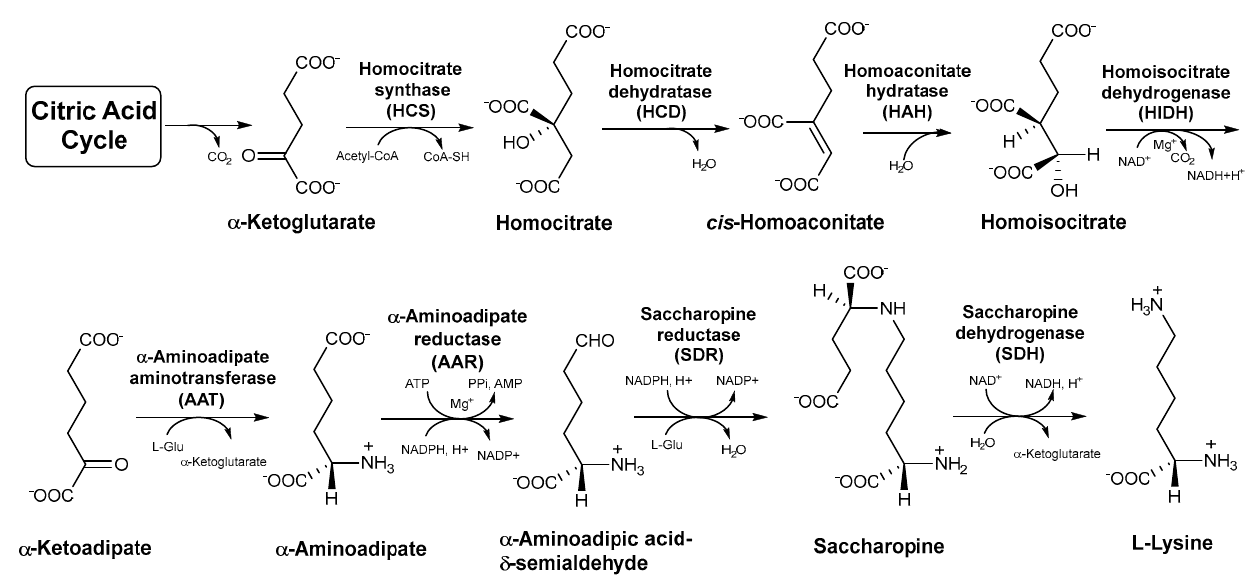
Figure 1. The α− aminoadipate (AAA) pathway of lysine biosynthesis in higher fungi. The origin and evolution of the lysine biosynthetic pathway is a key step in cellular evolution because it changes the dependence of primitive cells on the external environ- ment [9]. Based on the conservation of the amino acid sequences of specific enzymes in the pathways, Velasco and colleagues showed that the enzymes in the DAP pathway are related to arginine metabolism, and the enzymes in the AAA pathway are involved in leucine metabolism [13]. This is the first simple description of the evolutionary relation- ships of the lysine biosynthetic pathway, but this study does not cover the relationship between the lysine biosynthesis pathway and the evolution of species in Basidiomycota [13]. Torruella et al. explained the evolutionary history of lysine in eukaryotes based on the phylogenetic relationship between α -aminoadipate reductase (AAR) and LysA genes, and confirmed that the AAR gene is a molecular synapomorphy of fungi and protist Coral- lochytrium limacisporum [14]. However, the study only involves the homology of AAR from four species in Basidiomycota. Among the eight enzymes in the AAA pathway, ho- mocitrate synthase (HCS) catalyzes the first step in lysine biosynthesis. The condensation of acetyl-CoA and α -ketoglutarate to form homocitrate is considered to be the rate-limiting step in the biosynthesis of lysine [2]. AAR catalyzes the reduction of α -aminoadipate to a semialdehyde, which is the most striking transformation in the biosynthesis of lysine in fungi. It is considered to be a completely unique mechanism in the primary metabolism of fungi [10]. The last step of the AAA pathway of lysine biosynthesis is a key step catalyzed by saccharopine dehydrogenase (SDH) in higher fungi. SDH catalyzes the cleavage of saccharopine with the aid of NAD+ to generate α -ketoglutarate and L-lysine. [10]. In recent years, the number of Agaricomycetes species whose genomes and transcriptomes have been sequenced is increasing, providing us with indispensable sequences with which to study the evolution of lysine biosynthesis in Agaricomycetes [15,16]. To date, the evolutionary relationship of lysine biosynthesis in Agaricomycetes is un- clear. In this study, the phylogenetic relationship of lysine biosynthesis in Agaricomycetes was analyzed based on the reported sequences of the enzymes involved in the AAA path- way, especially HCS, AAR, and SDH, and the structural characteristic of proteins and the binding sites in predicted spatial structures. There is evolutionary conservation of lysine biosynthesis with evolution at the order level in Agaricomycetes.